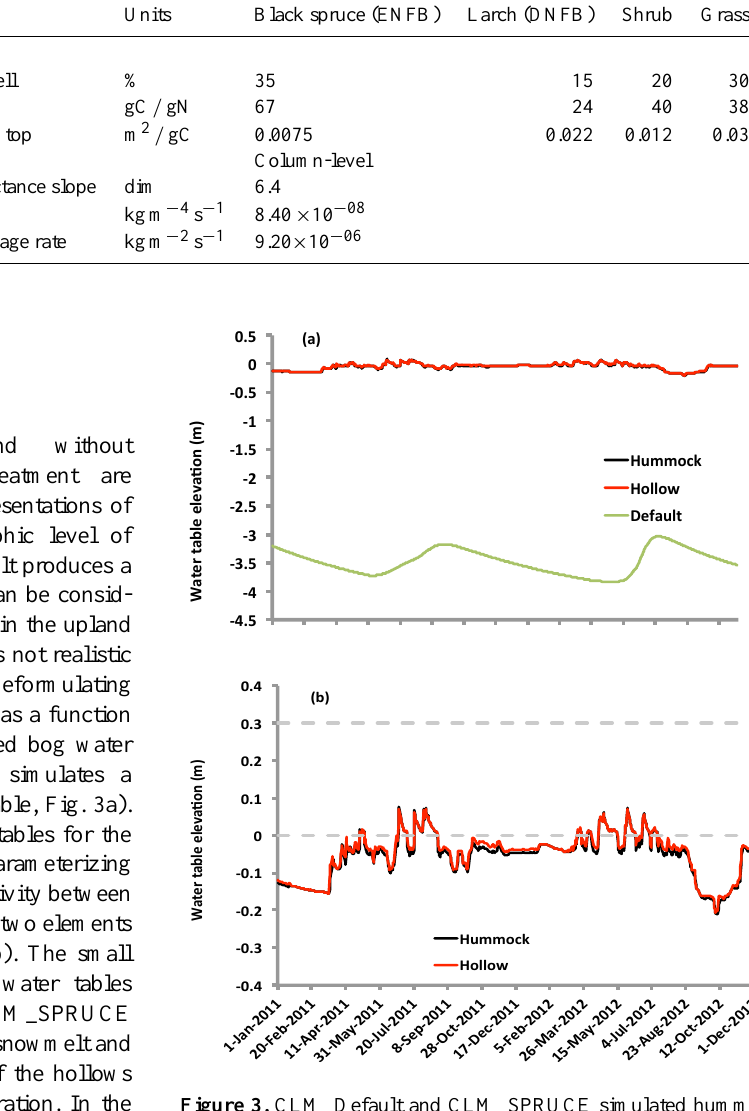
Figure 3. CLM_Default and CLM_SPRUCE simulated hummock and hollow water table levels (a) , and CLM_SPRUCE predicted wa- ter table dynamics (b) for years 2011 and 2012. Dashed lines show the height of the surface of the hummock (0.3m) and hollow